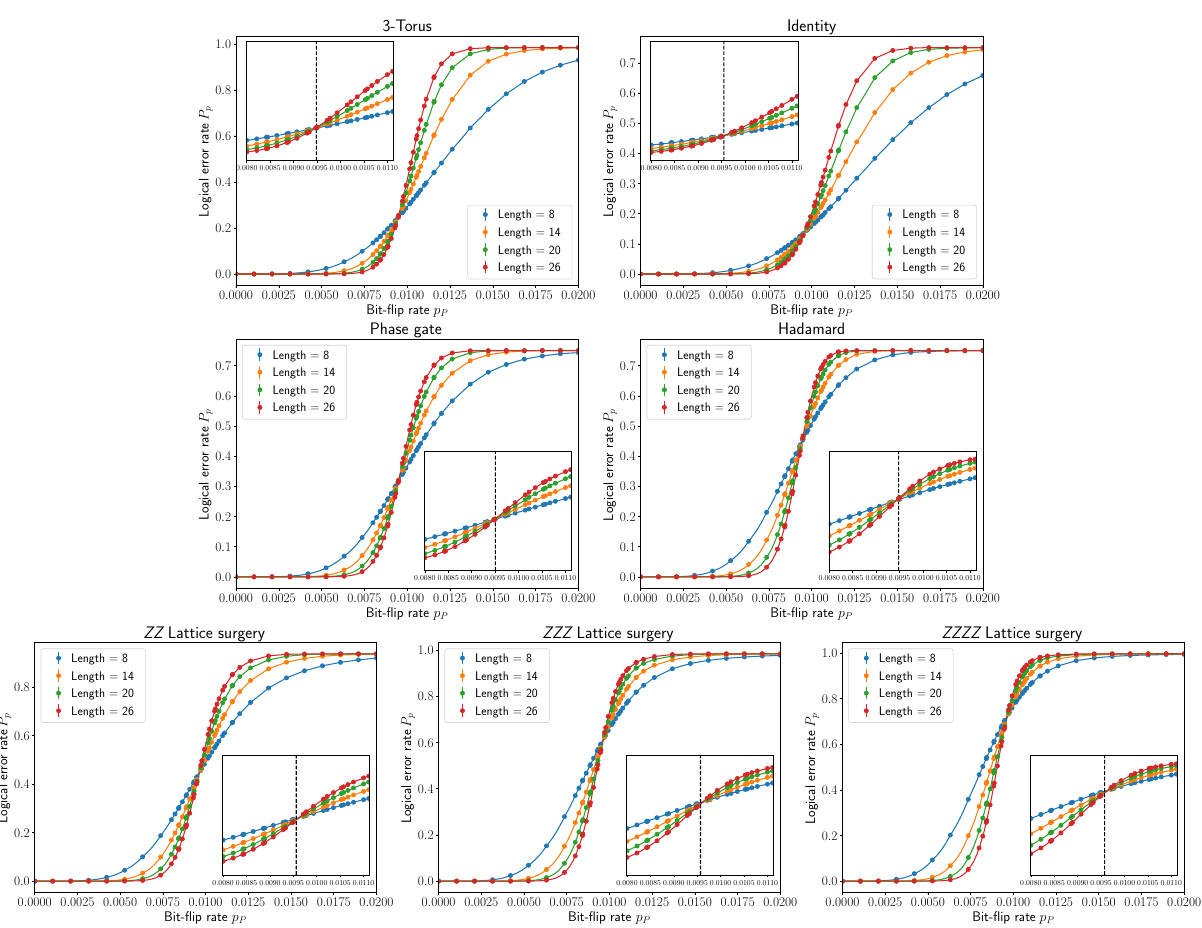
FIG. 26. Threshold crossing plots as per Fig. 25, but under IID bit-flip noise.